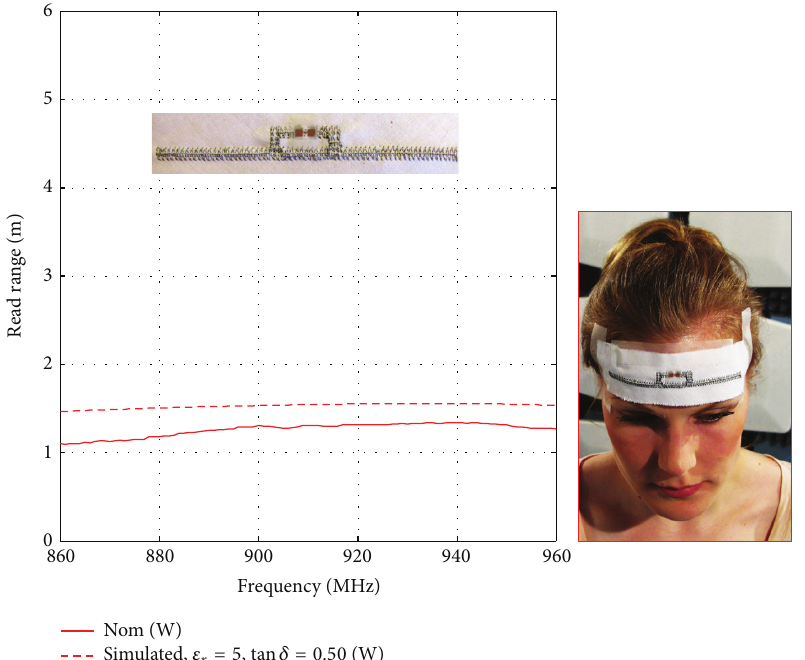
Figure 20: Measured and simulated embroidered tag on human head and on human head model, respectively. The embroidered tag is not responding on the male human